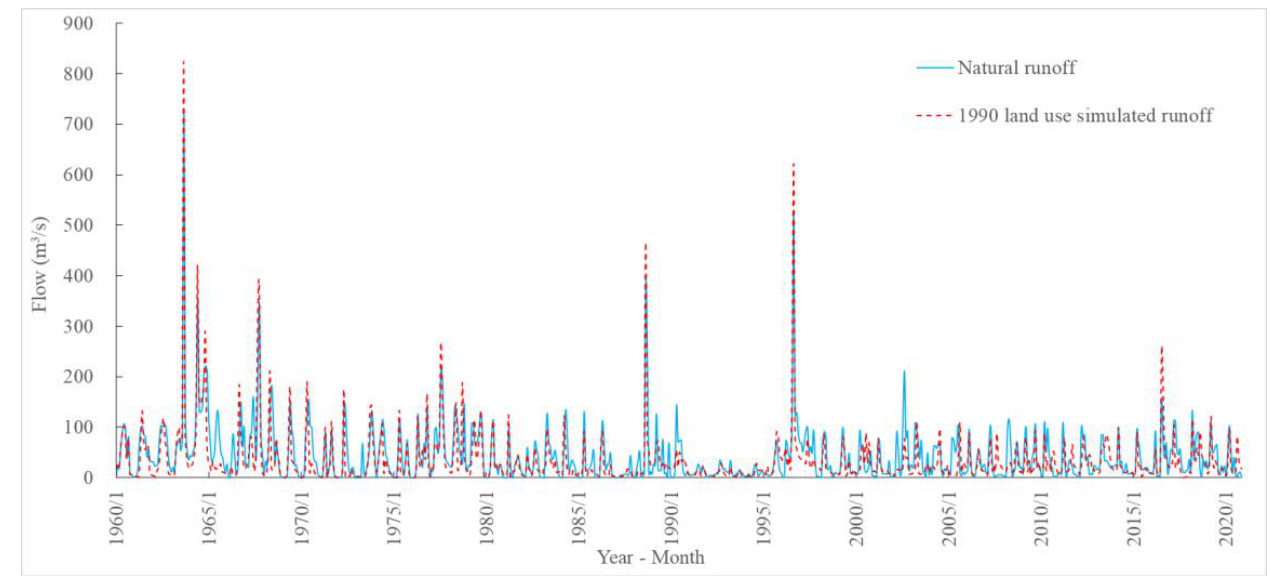
Figure 4. Comparison of simulated and natural runoff under the land-use scenario of 1990 at the Huangbizhuang Station.